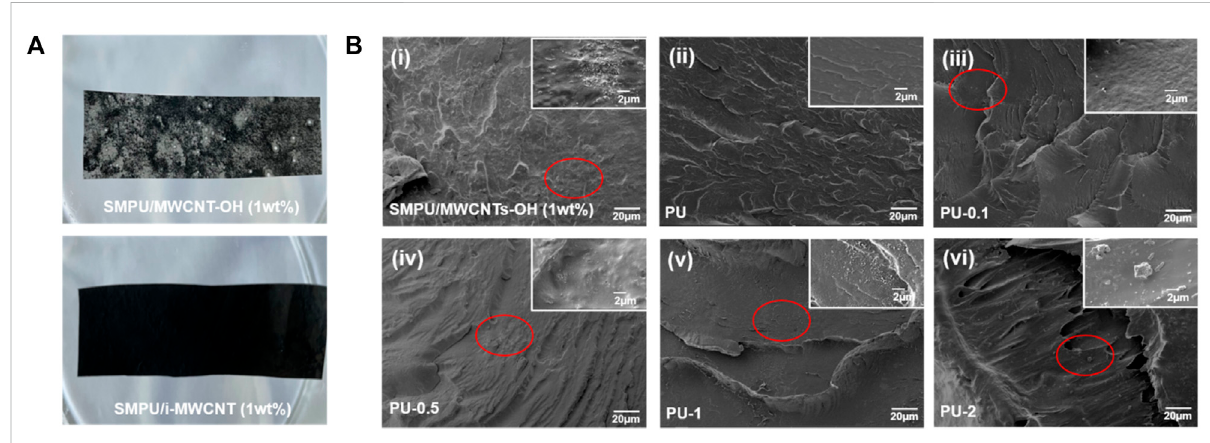
FIGURE 4 (A) The grossappearances ofSMPU/MWCNT-OH andSMPU/i-MWCNT compositeswith MWCNT-OHor i-MWCNT contents of1 wt%. (B)